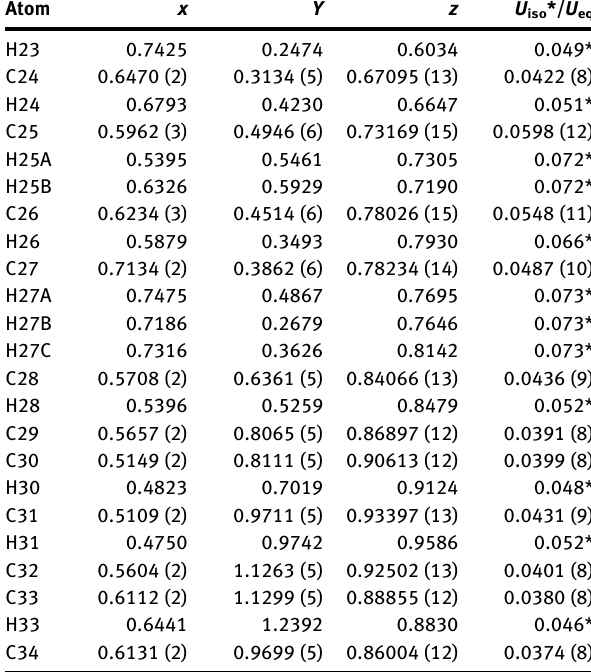
Table  : Fractional atomic coordinates and isotropic or equivalent isotropic displacement parameters (Å 